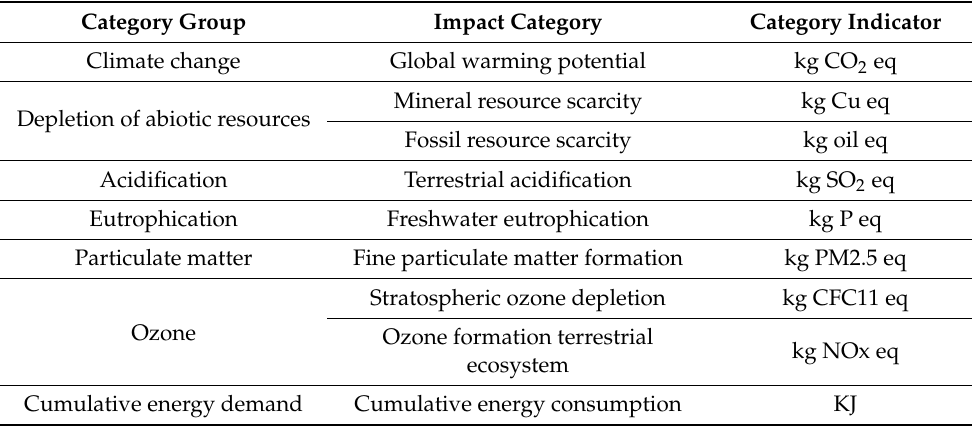
Table 6. Impact categories selected from ReCiPe and CED.